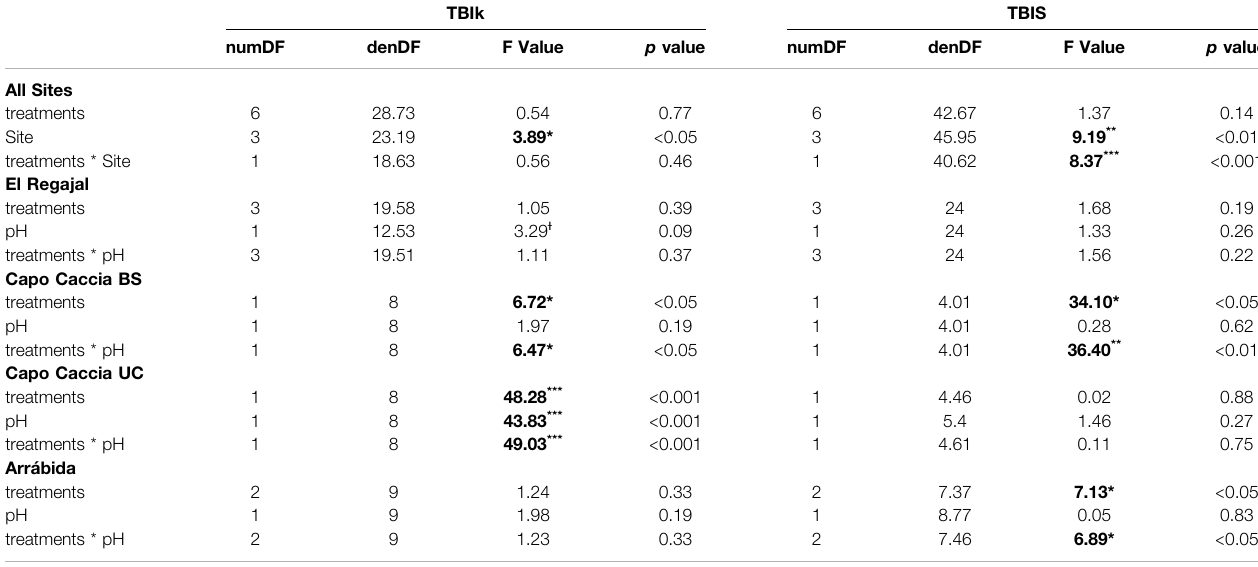
TABLE 5 | Results of the generalized linear mixed models (GLMMs). In All Sites ( n (cid:2) 13) the GLMMs accounts for the interaction between treatments and Sites as fi xed factors, the pH as covariate and the experimental designs of all sites were included as random factors on the decomposition rate (TBIk) and stabilisation factor (TBIS) response.CapoCacciaBSandCapoCacciaUCindicatebaresoilandundercanopymicrosites,respectively.InElRegajal(Spain, n (cid:2) 6),CapoCacciaBS(Italy, n (cid:2) 4),Capo CacciaUC(Italy, n (cid:2) 4),andArrábida(Portugal, n (cid:2) 3),theGLMMsaccountsfortheinteractionbetweentreatmentsandpHas fi xedfactorswhiletherespectiveexperimental designswereincludedasrandomfactorsonTBIkandTBISresponse.Statisticaldifferencesareindicatedas* p < 0.05,** p < 0.01,and*** p < 0.001andarehighlightedin bold. Ɨ is used to designate a value with p ≤ 0.1.